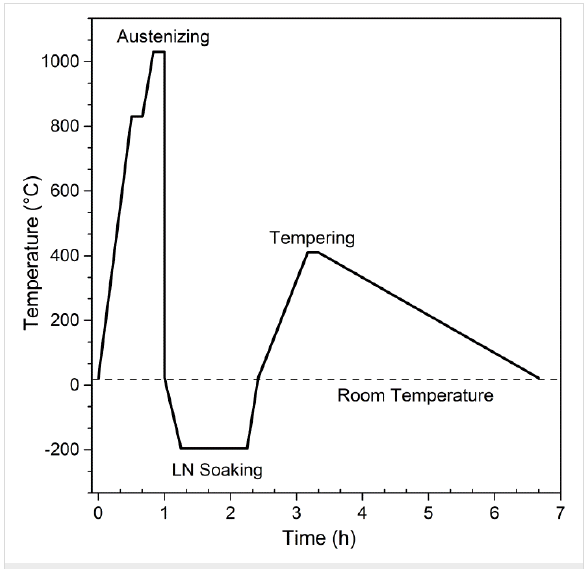
Figure 1: Representation of the applied cryogenic